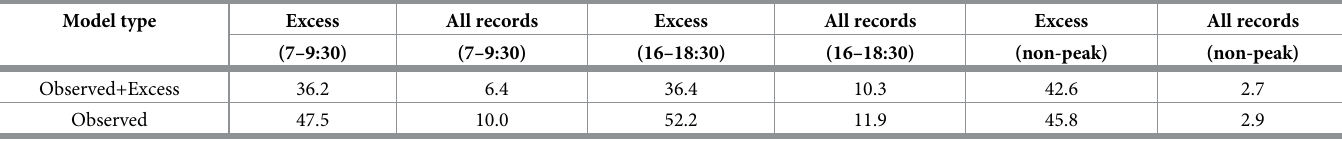
Table 4. MSE of different time periods under Skellam